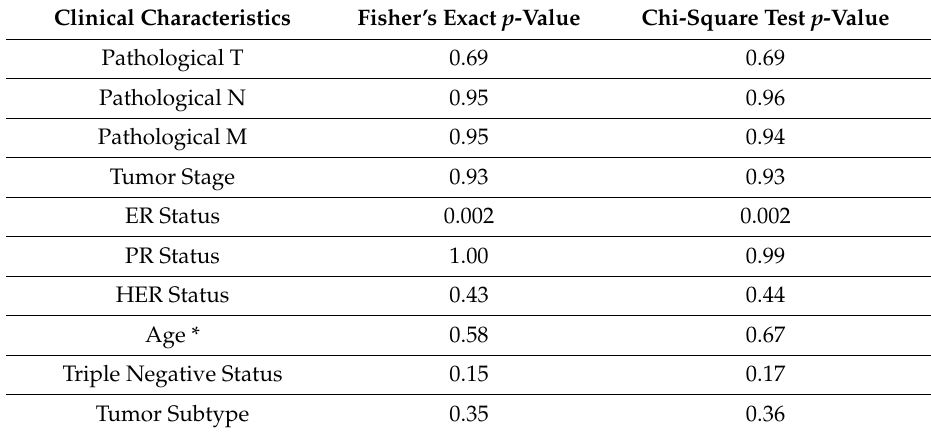
Table 2. The results of clinical association analysis. * patients were classified as young (age < 40) and old (age ≥ 40) groups.